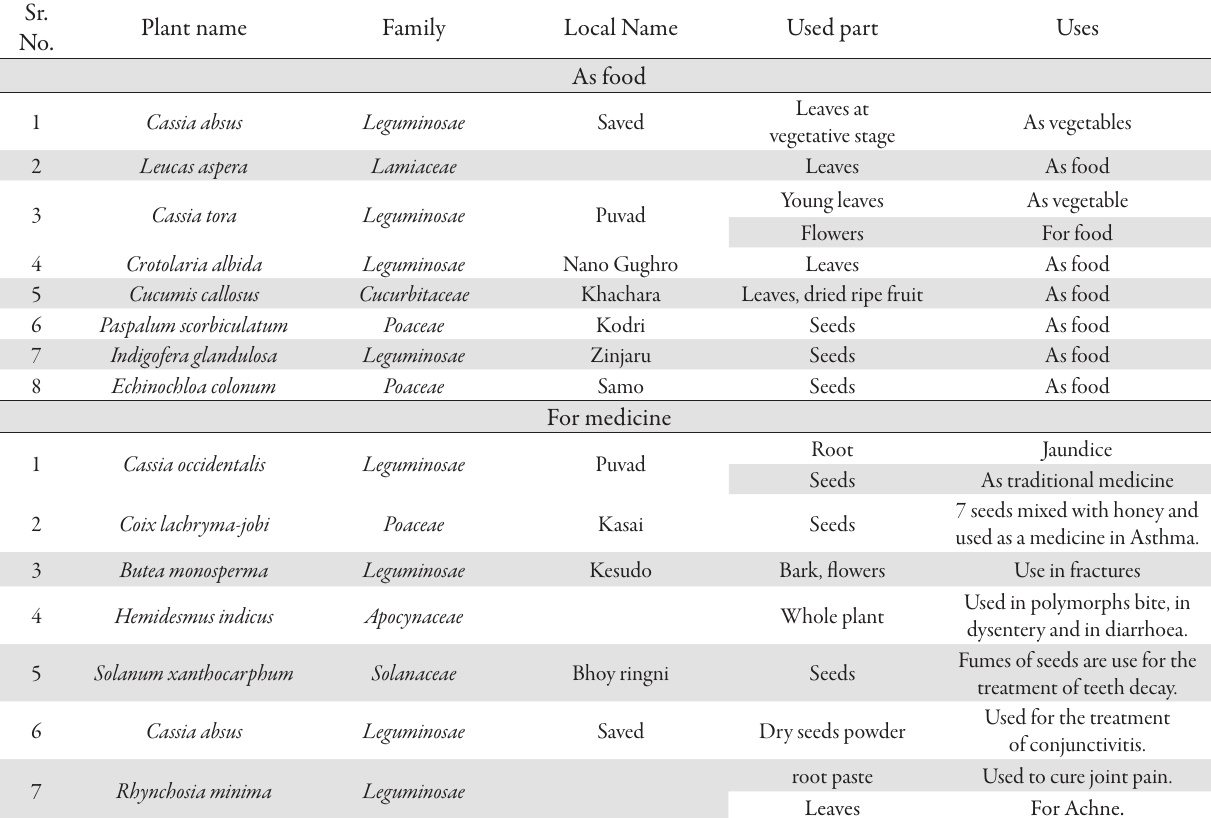
Tab. 4. List of plants which are used as food or medicinal purposes